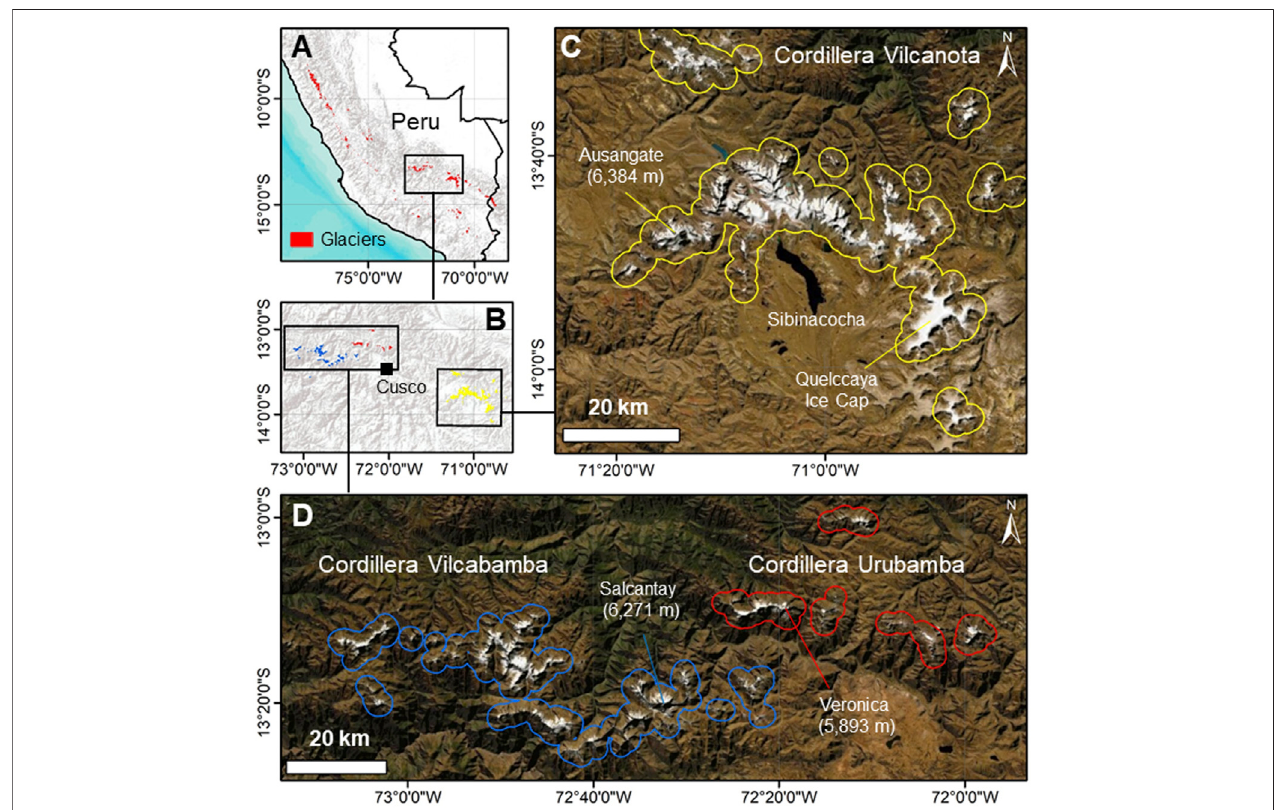
FIGURE1| LocationoftheSouthernPeruvianCordilleraswithin (A) Peruand (B) theCuscoregion. (C) TheCordilleraVilcanotaoutlinedinyellow(witha2 kmbuffer around glacierised areas), and (D) The Cordilleras Vilcabamba (blue) and Urubamba (red). Satellite imagery from DigitalGlobe. Glacier outlines from RGI Consortium (2017) (A) and this study (B – D)